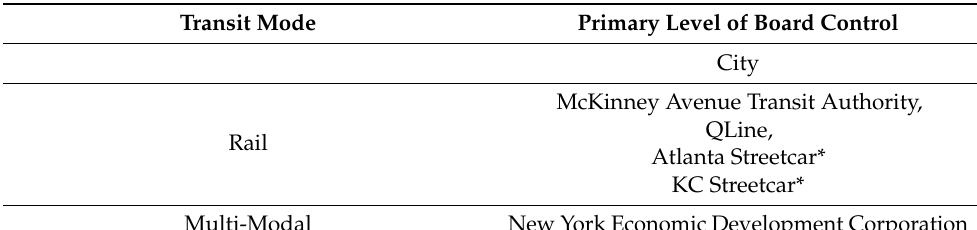
Table 5. Sub-Municipal Governance by Level of Control and